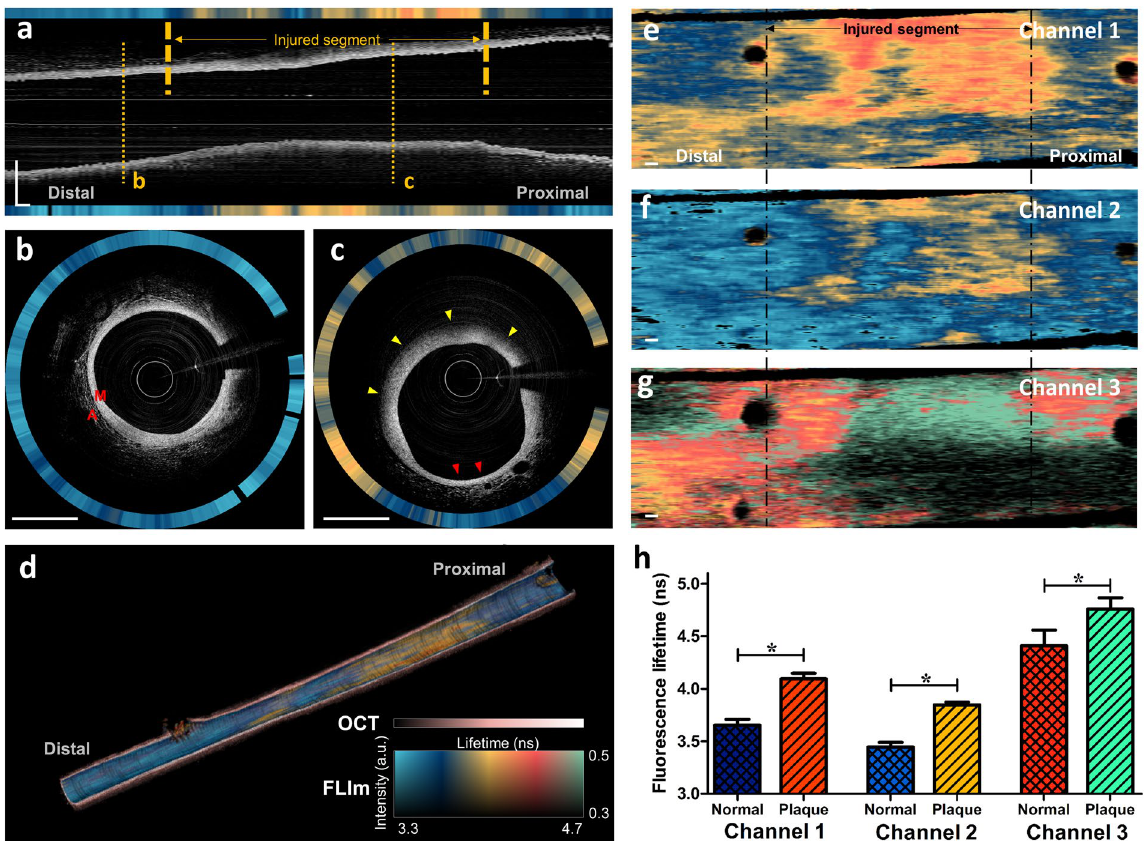
Figure 4. In vivo OCT/FLIm imaging results in a rabbit aorta. ( a ) Longitudinal OCT/FLIm images of a rabbit aorta. Grayscale and pseudo color represent the OCT image and fluorescence lifetime, respectively. ( b ) Representative cross-sectional image of normal aorta. Structures of normal aorta, including media (M) and adventitia (A) are clearly visible. ( c ) Representative cross-sectional image of atherosclerotic plaque. It shows lipid-rich plaque with thickened media and diffuse borer (yellow arrowheads) suggesting presence of lipid in OCT, and it also contains normal area (red arrowheads). ( d ) 3D rendering longitudinal cut-view image. The fluorescence lifetime is overlaid on the luminal surface of the OCT 3D rendering. The fluorescence lifetime in ( a – d ) was measured on channel 2. The 2D fluorescence lifetime maps measured on channel ( e ) 1, ( f ) 2, and ( g ) 3. The horizontal and vertical directions are the pullback direction and rotational direction, respectively. ( h ) Comparison of the averaged fluorescence lifetime between the normal aorta and atherosclerotic plaque. Results are presented as means ± standard deviation. * P < 0.001, by unpaired t-test. Scale bars: 1 mm. M, media; A,